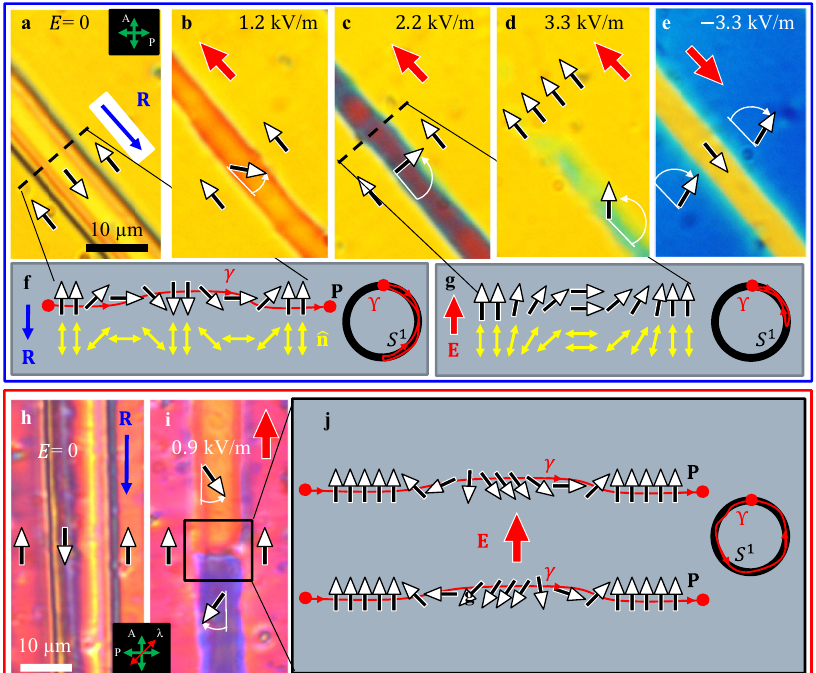
Fig. 3 Electric fi eld switching of 360 o DW pairs. a – d POM textures of topologically trivial S-pair that are smoothly realigned into a uniform state by the electric fi eld of an appropriate polarity. e An opposite fi eld polarity tilts P in two wide domains, but does not cause a complete reorientation, contrary to the case of the narrow domain in ( d ). f Topological scheme of the S-pair shown in ( a ). P rotates CW in the left DW and CCW in the right DW, thus Q = 0. g Topological scheme of the S-pair shown in ( c ). P in the central narrow domain could rotate only CCW as the fi eld increases. h , i POM textures (with an added waveplate) of a topologically stable 360 o W-pair of DWs, Q = 1; increase of the electric fi eld could cause both CW and CCW rotations of P within the same DW pair, as schematized in ( j ). Cell thickness 4.7 µ m in all